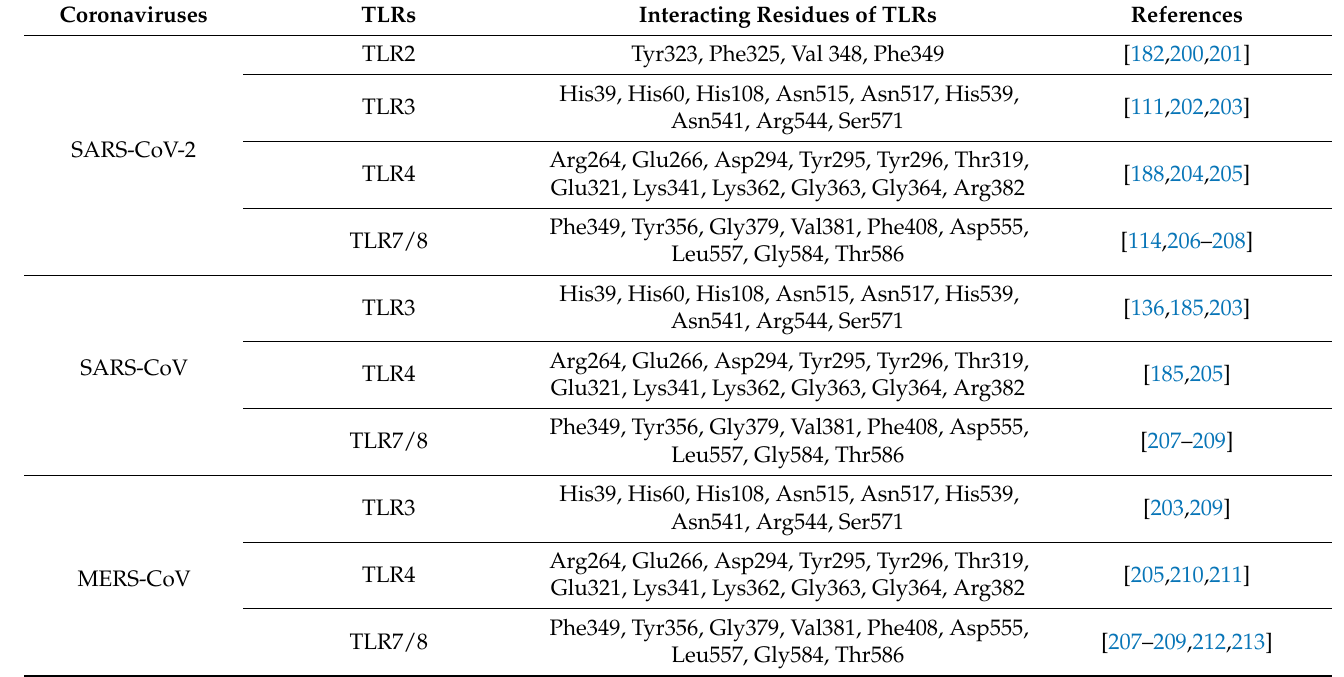
Table 5. The interaction of Toll-like receptors (TLRs) with SARS-CoV-2 and other coronaviruses. Coronaviruses TLRs Interacting Residues of